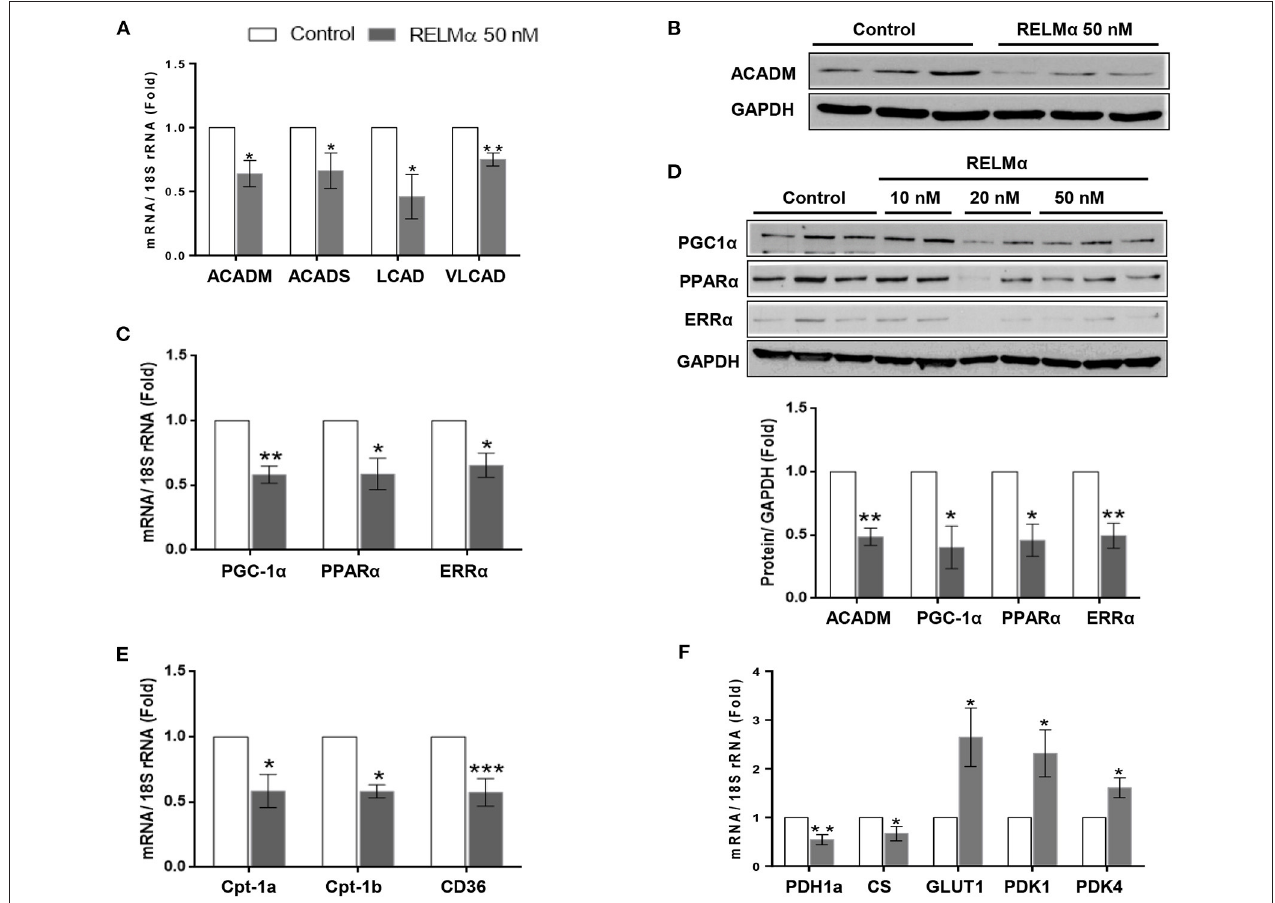
FIGURE 1 | RELM α downregulates genes related to cardiac energy metabolism. (A) Quantitative PCR analyses of acyl-coenzyme A dehydrogenase straight chain (ACADM), acyl-coenzyme A dehydrogenase short chain (ACADS), long-chain acyl-CoA dehydrogenase (LCAD), and very long-chain acyl-CoA dehydrogenase (VLCAD) in total mRNA derived from neonatal rat cardiomyocytes (NRCMs) exposed to RELM α (50nM). (B) Immunoblotting of ACADM, peroxisome proliferator-activated receptor gamma coactivator 1- α (PGC-1 α ) and transcription factors PPAR α and ERR α in total protein extract derived from NRCMs exposed to RELM α at indicated concentration. (C) Quantitative PCR analyses of peroxisome PGC-1 α , PPAR α and ERR α in mRNA derived from NRCMs exposed to RELM α (50nM). (D) Relative quantification for immunoblots of ACADM, PGC-1 α , PPAR α , and ERR α in total protein extract isolated from NRCMs exposed to RELM α (50nM). (E) Quantitative PCR analyses of carnitine palmitoyltransferase-1a and 1b (CPT-1a and CPT-1b) and CD36 in total mRNA derived from NRCMs exposed to RELM α (50nM). (F) Quantitative PCR analyses of pyruvate dehydrogenase 1a (PDH1a), citrate synthase (CS), glucose transporter 1 (GLUT1), pyruvate dehydrogenase kinase 1, and 4 (PDK1 and PDK4) in total mRNA derived from NRCMs exposed to RELM α (50nM). n = 3–4/group. *, **, *** p < 0.05, 0.01, 0.001 vs. control